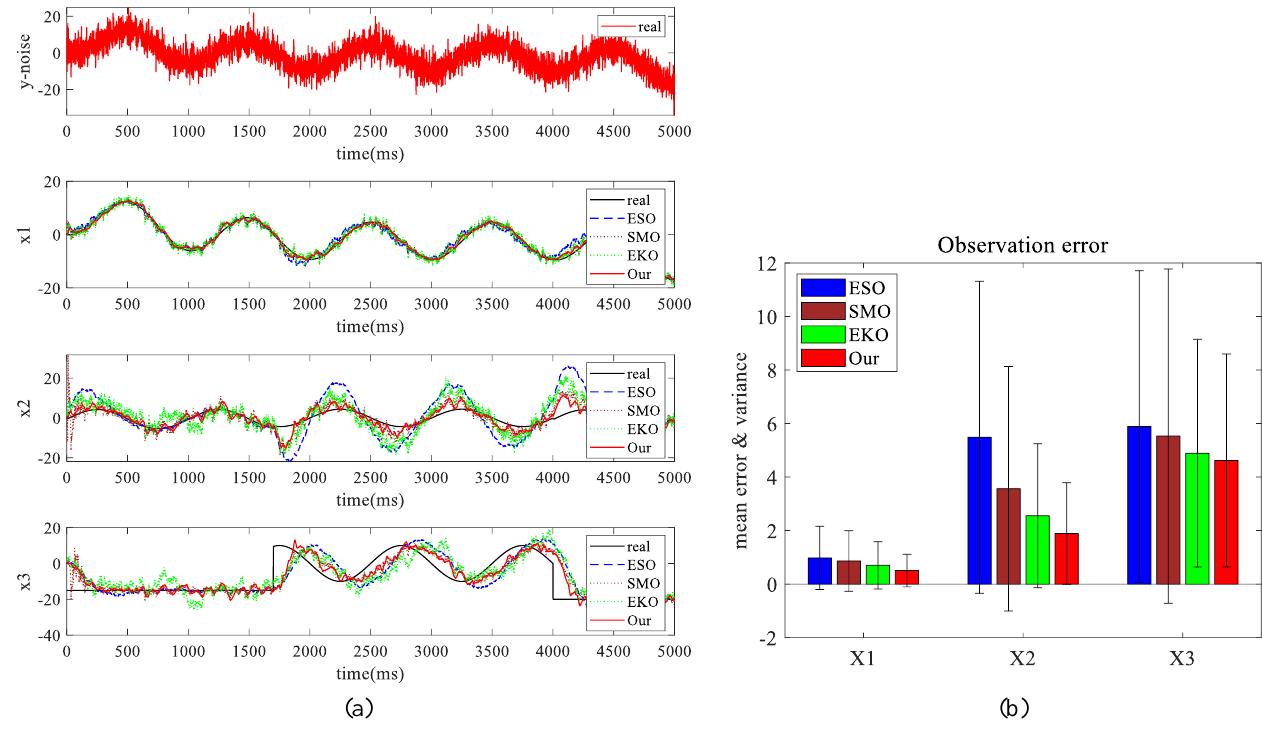
Figure 4. Comparison resultsof observation. ( a ) represents the observation result of position, velocity, and disturbance, ( b ) expresses the observation mean error and